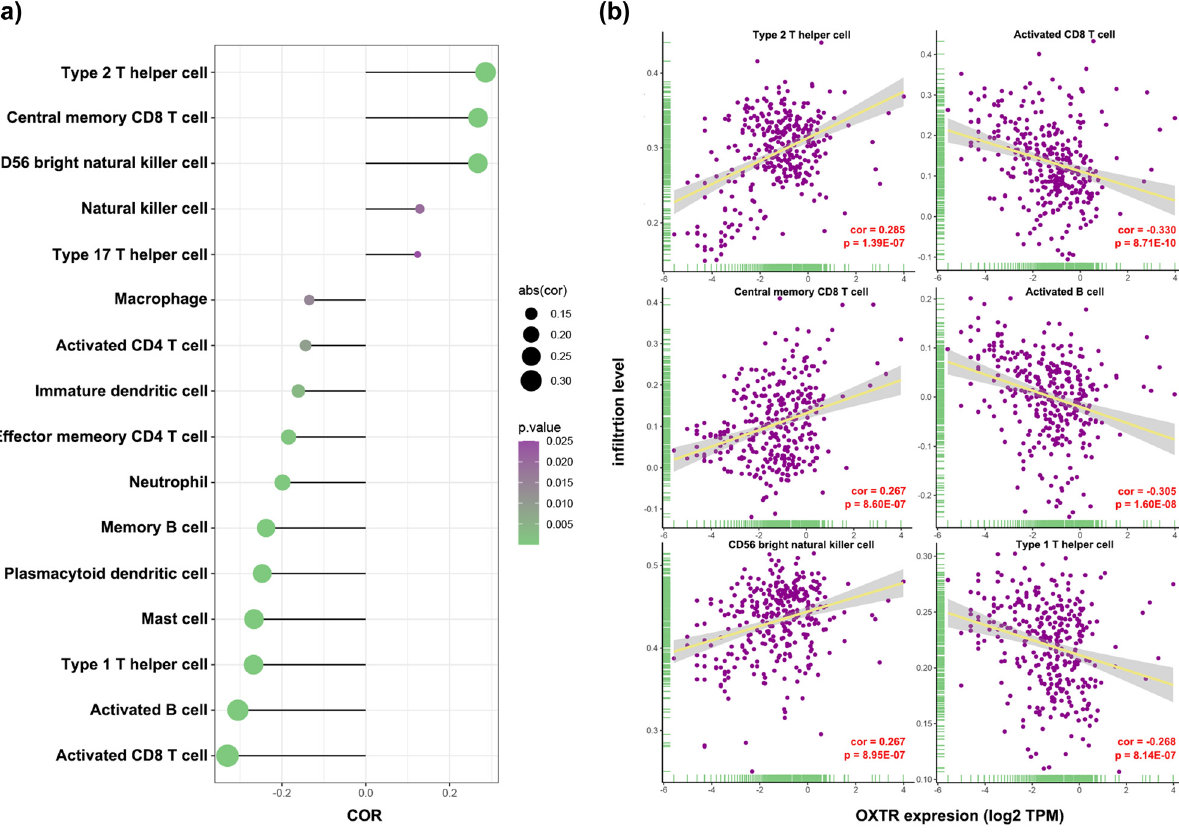
Figure 8: Correlations between OXTR expression and immune in fi ltration in COAD. ( a ) Rod diagram of the relationship between OXTR levels and in fi ltration levels of various immune cells. ( b ) Scatter plot of the association between OXTR levels and in fi ltration levels of type 2T helper cell, central memory CD8 T cell, CD57 bright natural killer cell, activated CD8 T cell, activated B cell, and Type 1T helper